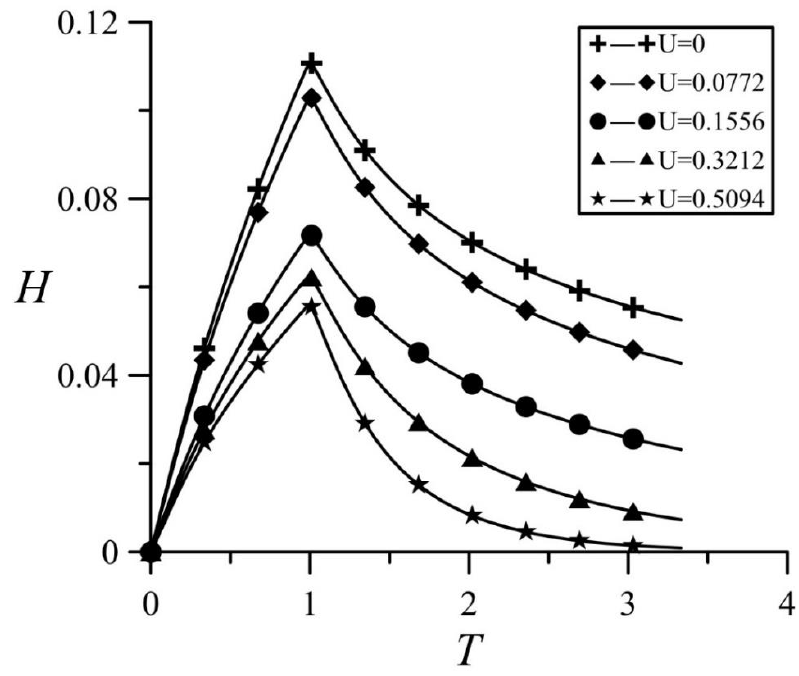
Figure 4. The groundwater level changes with different flow velocity factors 𝑈 ( X = 0.2 and 𝛼 =